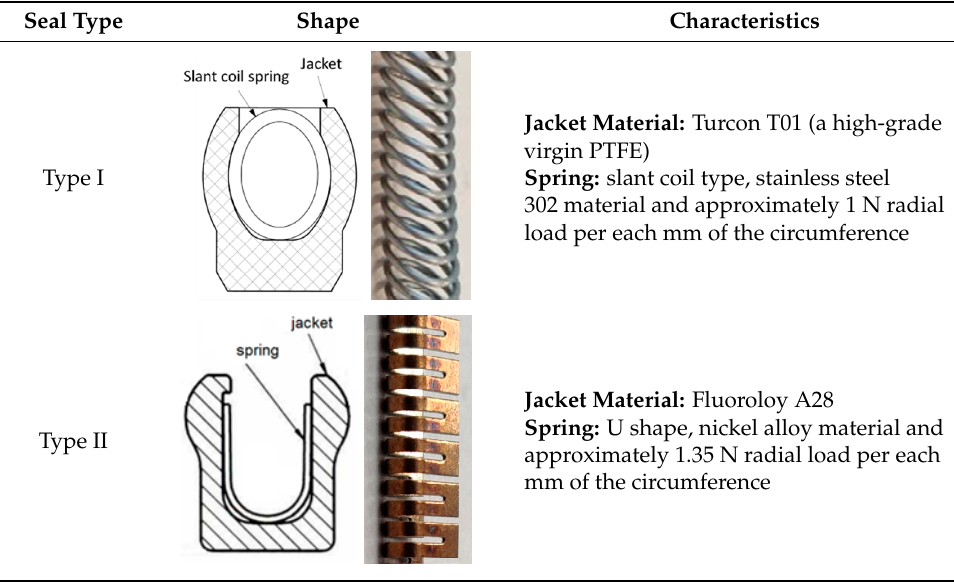
Table 2. Sealing elements main characteristics.